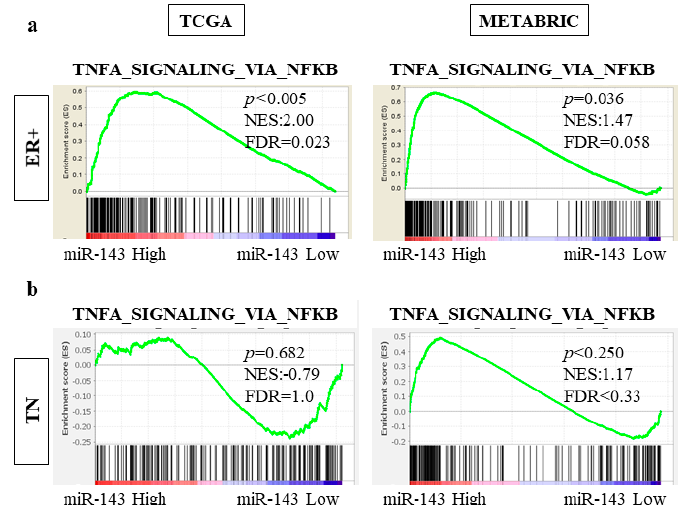
Figure 6. miR-143 high tumors enriched the genes related to TNF- α signaling pathways with only ER+ subgroups. ( a ) The genes related to TNF- α signaling pathway was enriched in ER+ subgroup; ( b ) The genes related to TNF- α signaling pathway was not enriched in TN subgroup. ER+, estrogen receptor positive; TN, triple negative.